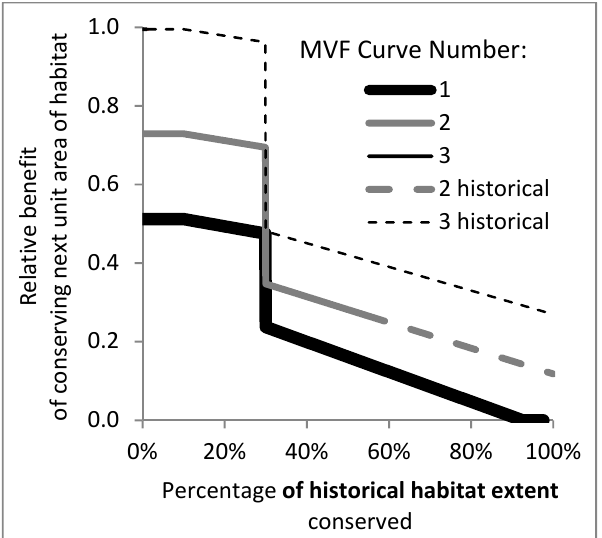
Figure 7. Adjusting the relative marginal value function based on habitat specific historical degradation. As a habitat is degraded, its marginal value function (MVF) rises in value relative to the other habitats. Using the parameters of the medium target emphasis MVF of Figure 6, and global habitats example [56], line 1 represents an element that is 97.6% intact (e.g., boreal forest biome globally), line 2 represents an element that is 54.2% intact (e.g., grassland/shrubland biome), and line 3 represents a hypothetical element that has lost 99% of its historical extent. In this case, the parameter value for differentiating these habitats up and down the Y-axis is set to 0.5. The dashed lines represent habitat already lost.